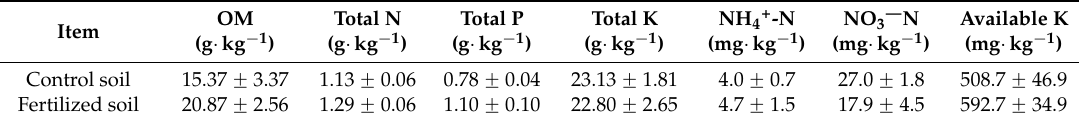
Table 3. Nutrients contents in control soils and soils fertilized with digested pig slurry.